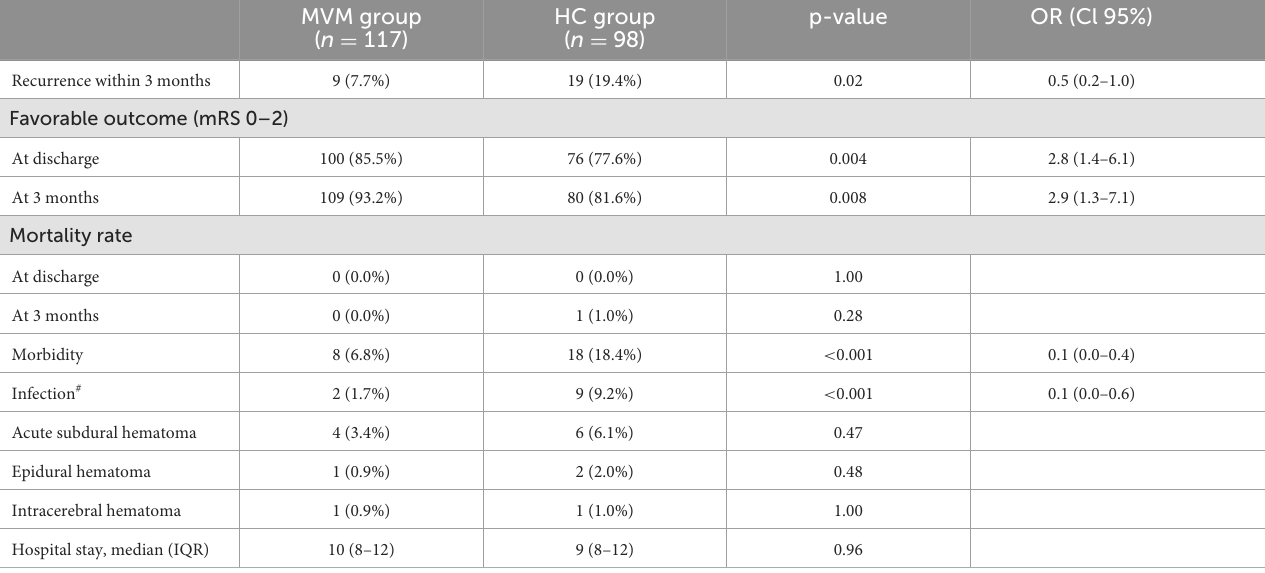
TABLE 3 Primary and secondary outcome analysis in MVM group and HC group ( N = 215).